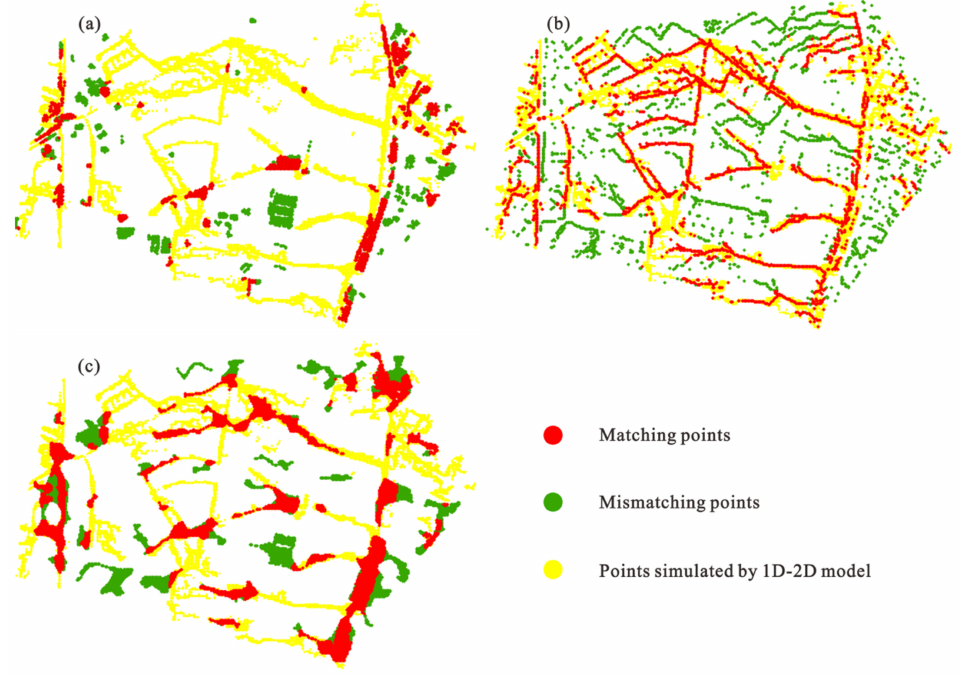
Figure 11. Spatial illustrations of flood maps using optimized ( a ) DE, ( b ) TWI and ( c ) refined methods based on the F3 indicator in the validation